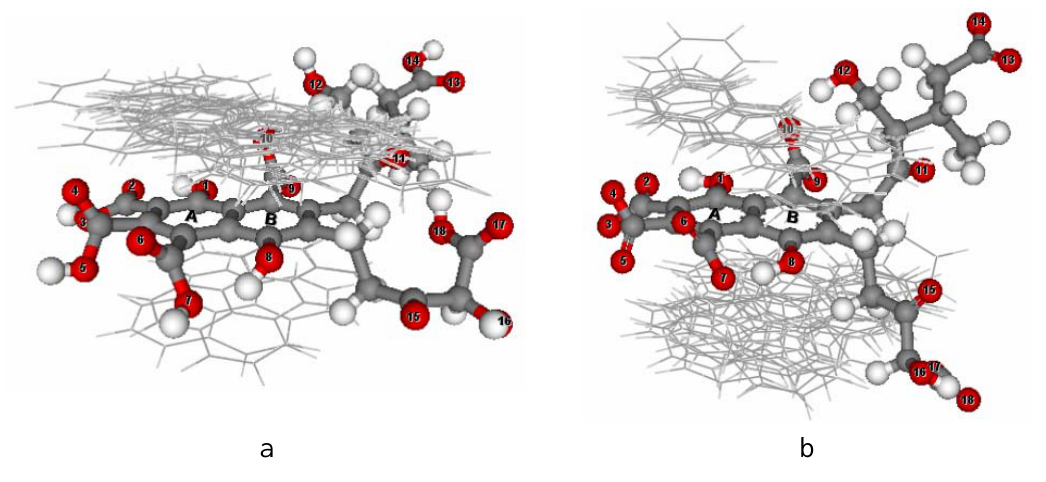
Figure 6 . Orientation of docked PAHs onto FA (a) and ionized FA